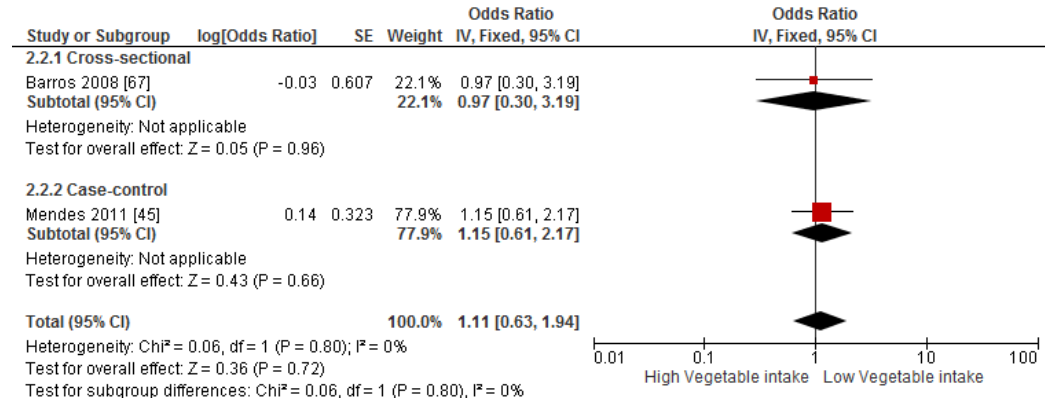
Figure 7. Meta ‐ analysis of the association between fruit intake and risk of prevalent wheeze.